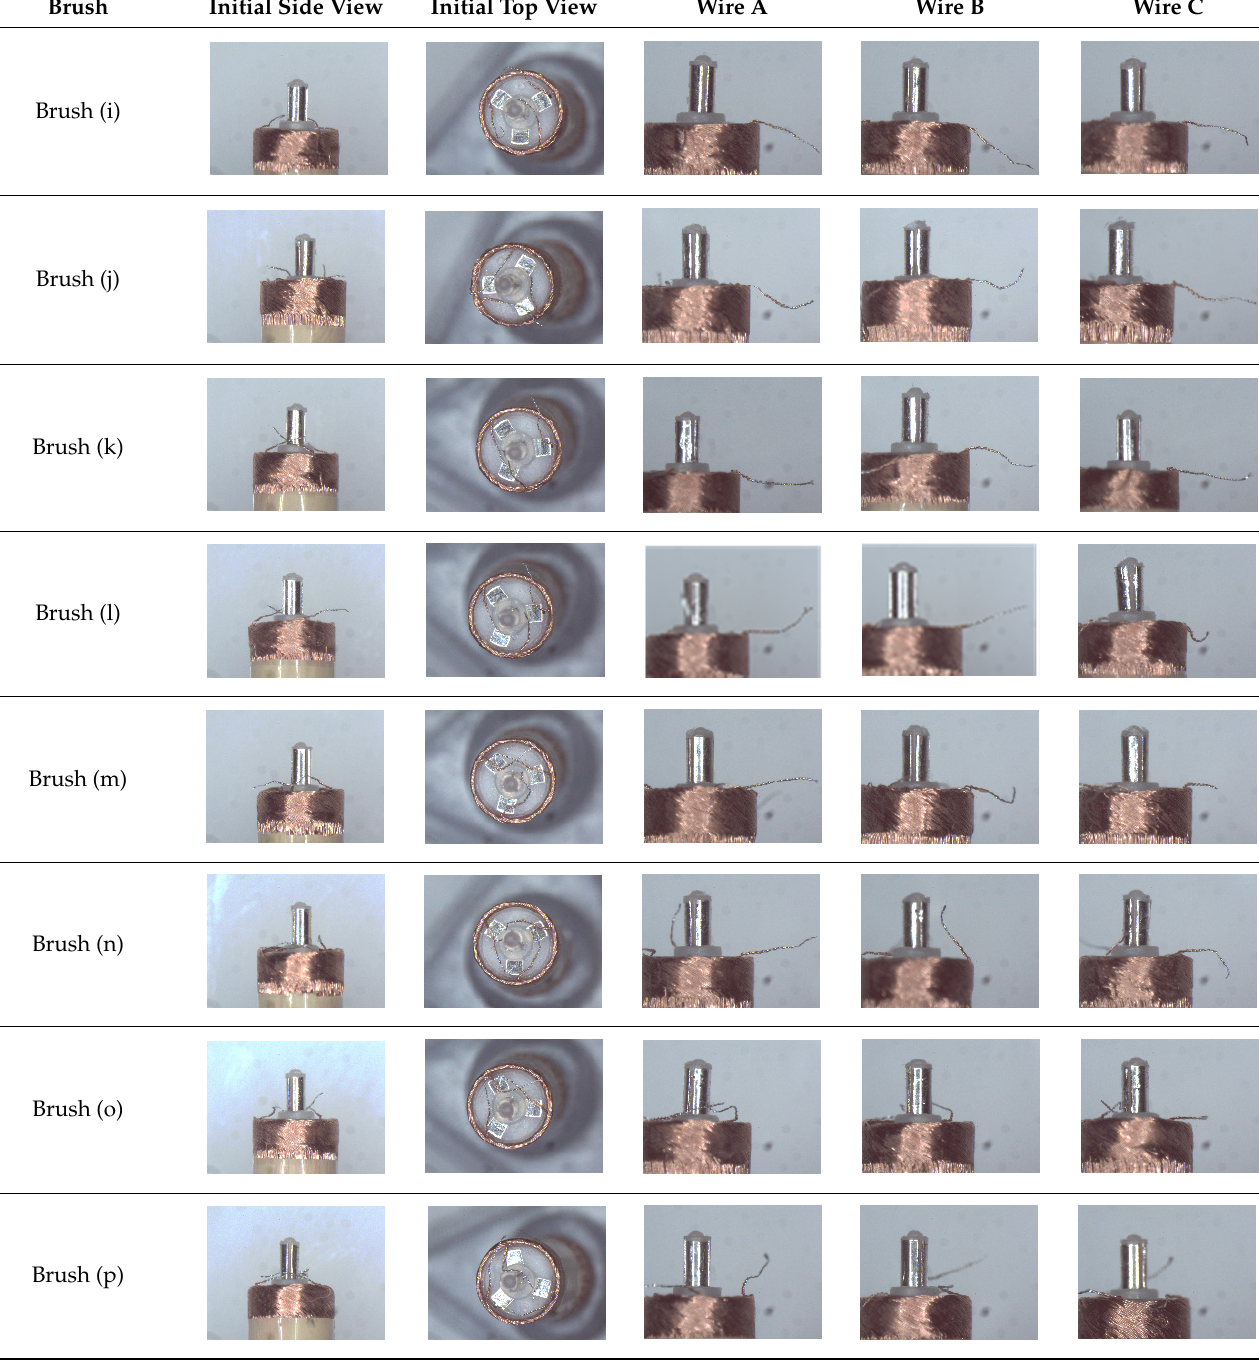
Table 7. Brushing results using micro-manipulators in Table 4 made by nanometer-silk and wool material.